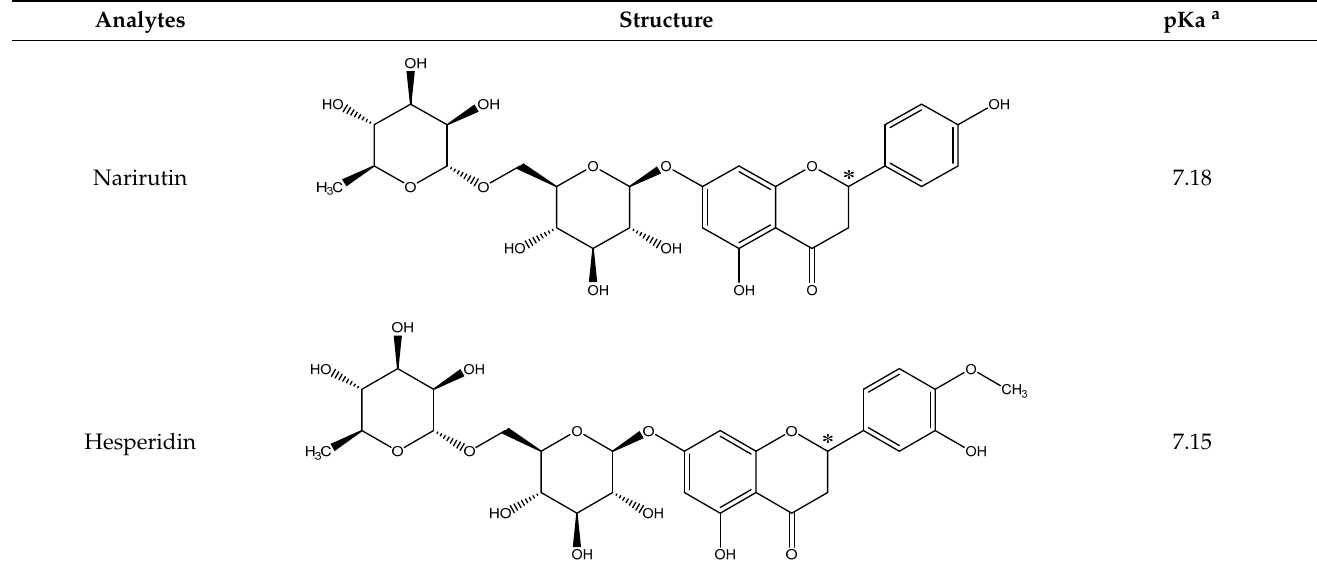
Table 1. The chemical structures and pKa values of two flavanones.